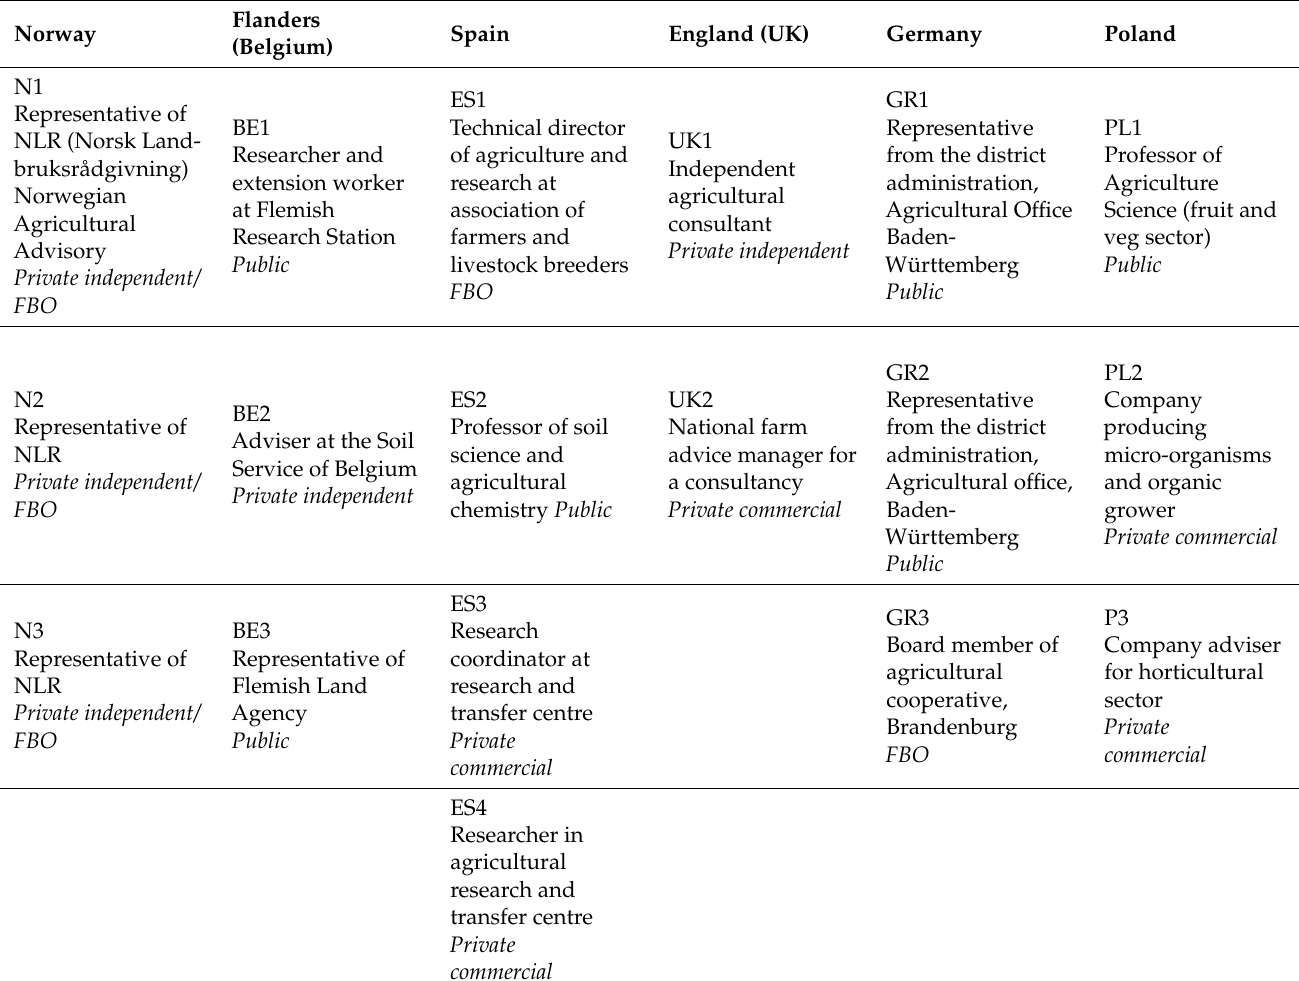
Table 1. The case study respondents and their roles and